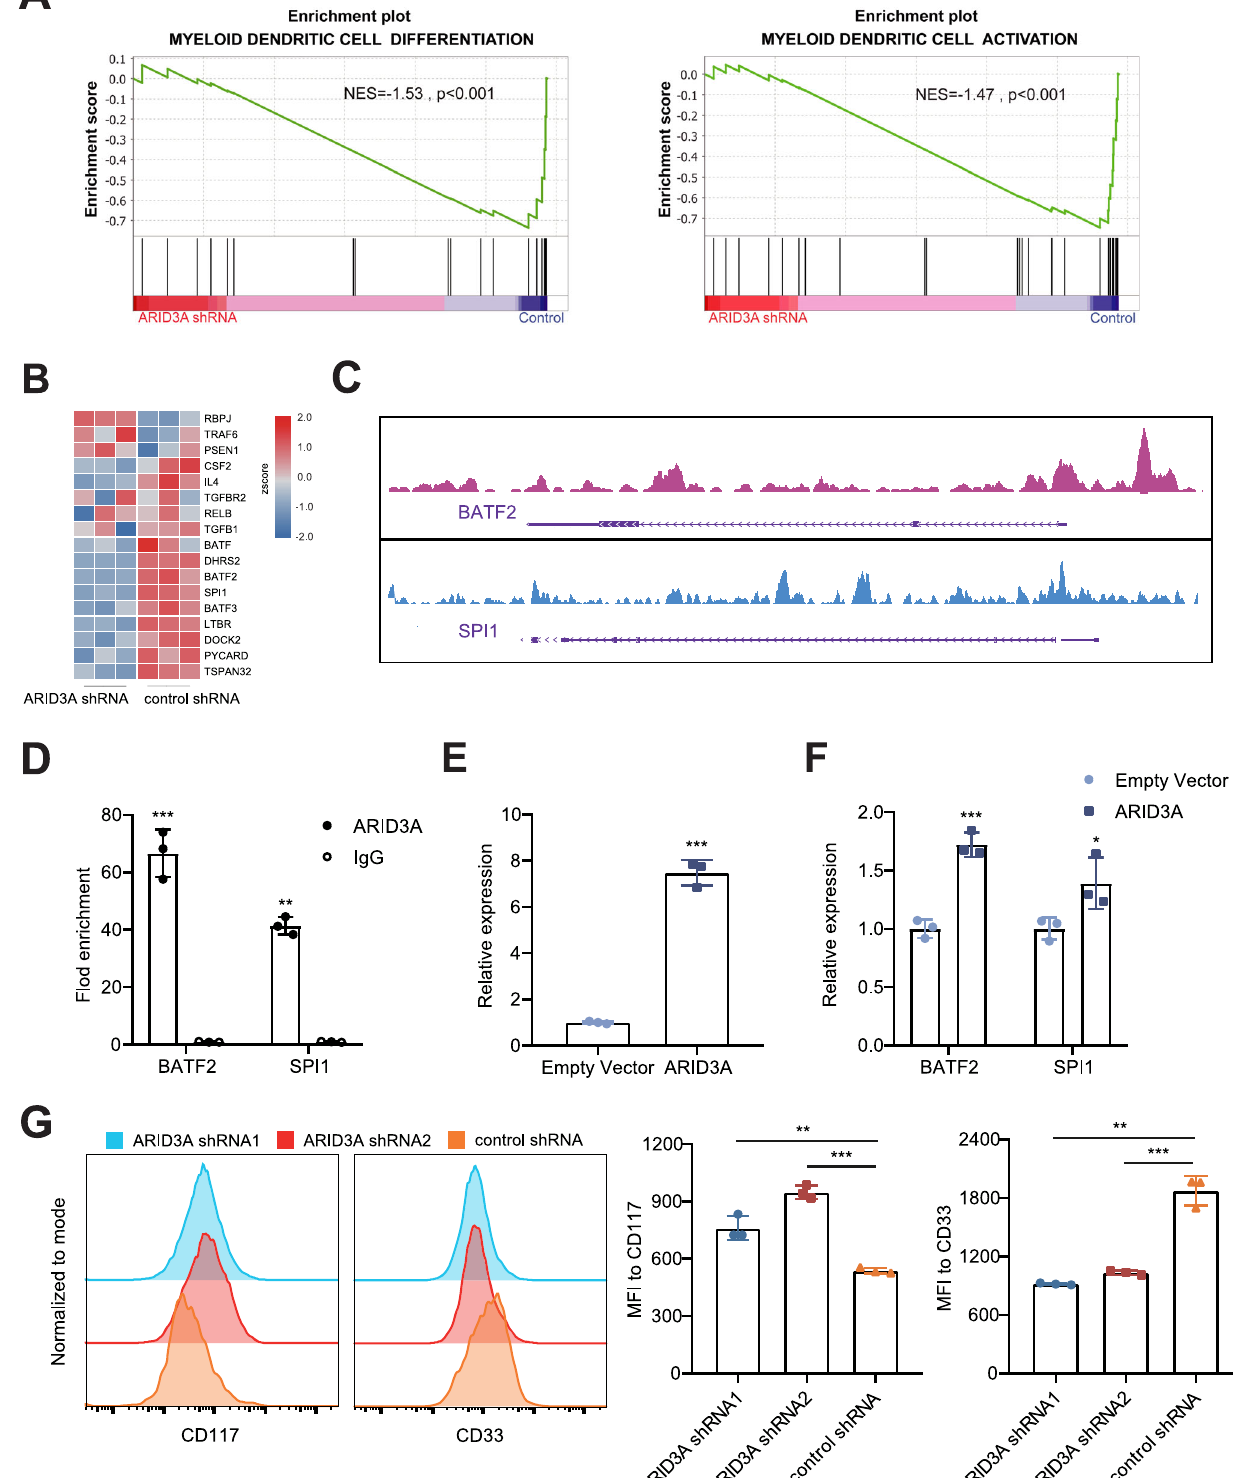
ARID3A after ARID3A plasmidoverexpressioninK562cells. F Relativeexpressionof BATF2 and SPI1 after ARID3A plasmid overexpression in K562 cells. G Flow cyto- metric measurement of surface antigen CD117 and CD33 after knock-down of ARID3A in K562 cells. Data are representative of three independent experiments (Mean ± SD for triplicates). P values are calculated using unpaired two-tailed Stu- dent ’ s t test and indicated signi fi cant if * p <0.05, ** p <0.01, or *** p <0.001. MFI mean fl uorescence intensity.